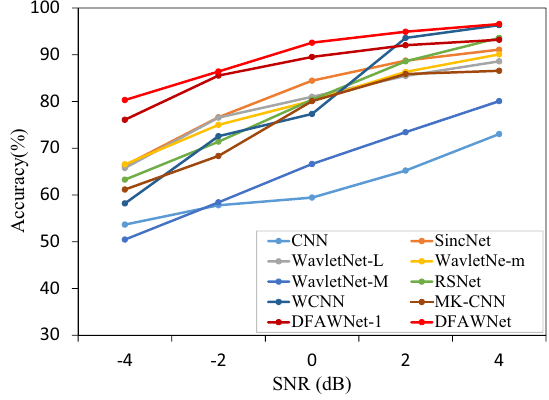
Figure 10 Model performance with different